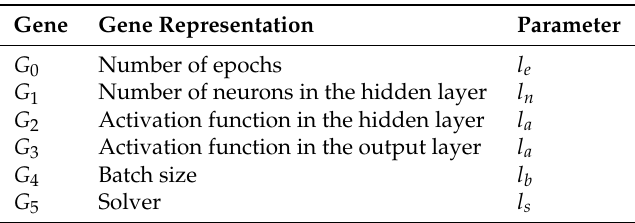
Table 5. Chromosome construction parameters for the case od MLP with one hidden layer.